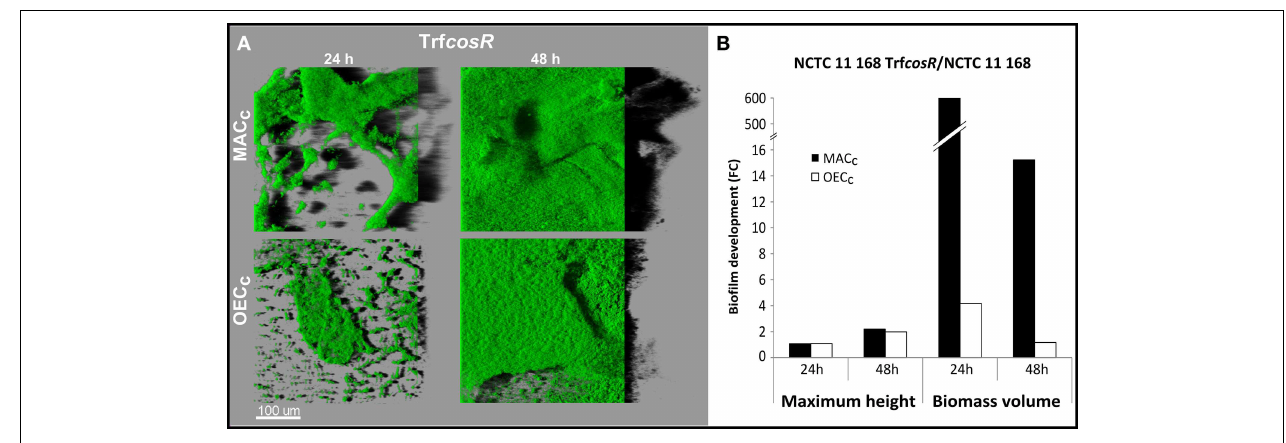
FIGURE 5 | The CosR is responsible for biofilm maturation in C. jejuni . Biofilm structure of C. jejuni NCTC 11168 and the cosR overexpressing transformant (Trf cosR ) after incubation for 24 and 48h in MAC (black bars) or OEC (white bars). (A) The CLSM images representing an